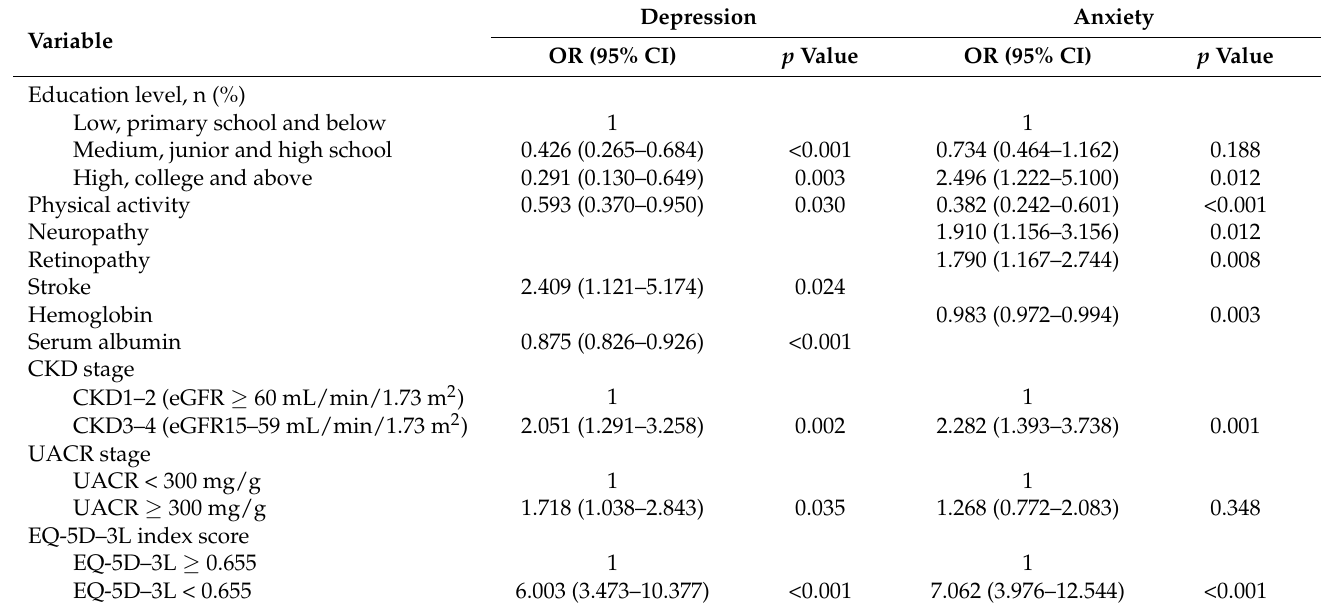
Table 4. The multivariate logistic regression analysis showing risk factors associated with depression and anxiety in the DKD patients.